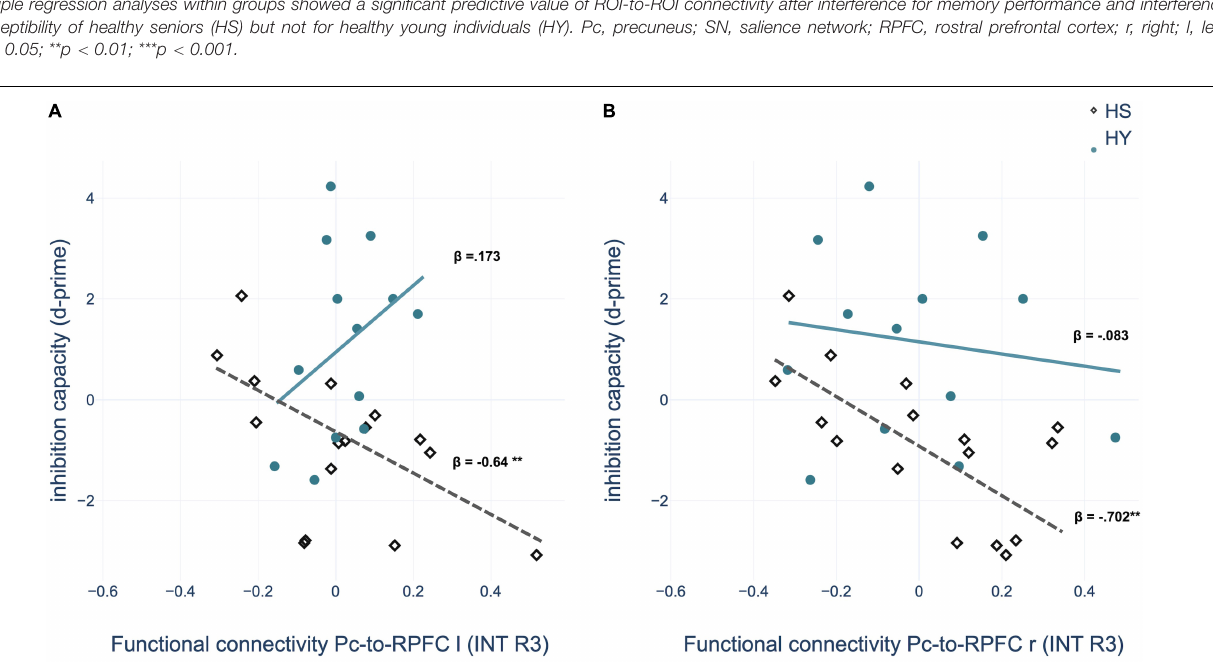
FIGURE 7 | Regression analysis showed that inhibition capacity is predicted by region of interest (ROI)-to-ROI connectivity between left precuneus (Pc) and (A) left rostral prefrontal cortex (RPFC) and (B) right RPFC during post-encoding rest in the interference condition for HS (healthy seniors) but not for HY (healthy